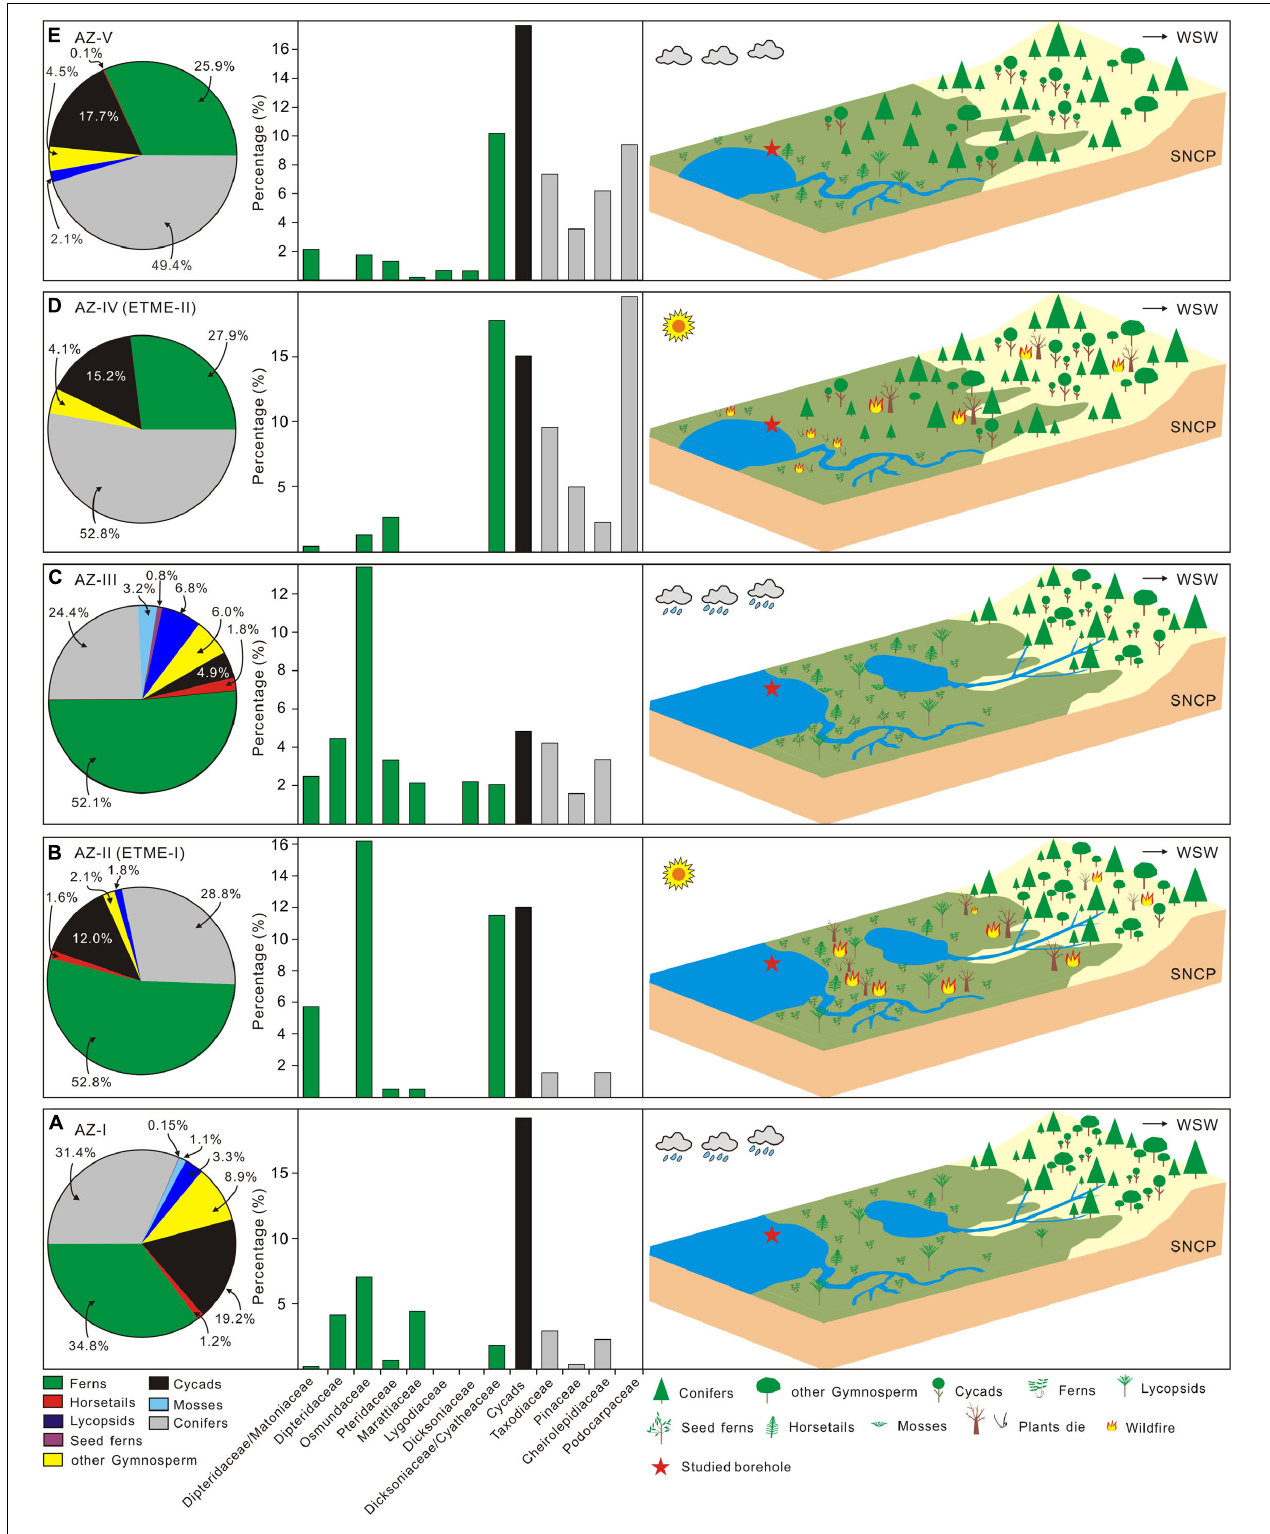
FIGURE 8 | Paleovegetation composition and paleoenvironmental reconstruction of the Jiyuan Basin illustrating five distinct (A–E) floral assemblages across the Triassic-Jurassic transition. AZ-I to AZ-V, palynology assemblage zone (AZ) I to the V; ETME-I, first stage of the end Triassic mass extinction; ETME-II, second stage of the end Triassic mass extinction; WSW, west-southwest; SNCP, southern North China Plate.